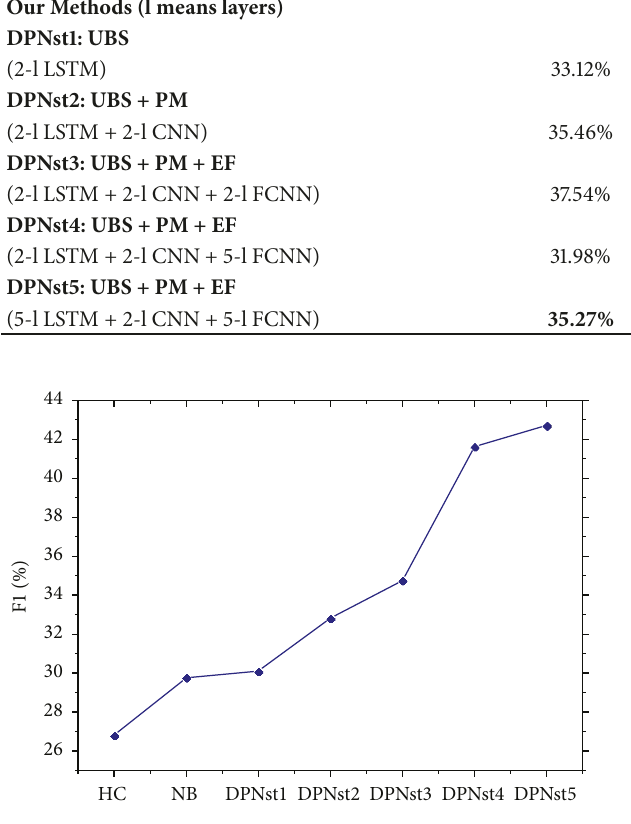
Figure 9: The destination prediction